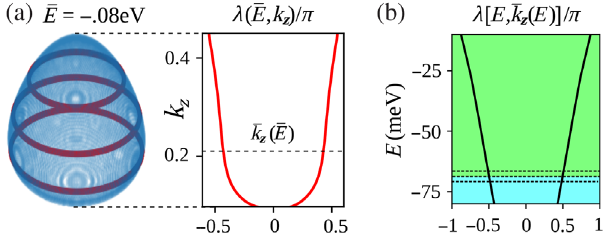
FIG. 3. Characterization of the 3D Dirac metal Na 3 Bi. (a) Left: ¯ E Surface of fixed energy ( ¼ − 0 . 08 eV measured from the 3D Dirac point); contours of fixed energy and k are illustrated by red z ¯ E; k circles. Right: Plot of f λ for a field parallel to the a ð z Þg a ¼ 1 ; 2 trigonal axis ( k ). k is measured in units where the reciprocal z z period ( 0 . 64 Å − 1 ) is unity; the minimum (maximum) k on the z plot corresponds to the south (north) poles of the constant-energy ¯ ¯ E k surface. The extremal orbit occurs at k Þ , indicated by a z ¼ z ð ¯ E; k E Þ(cid:3) vs E , for a range of E below the dashed line. (b) λ 1 ; 2 ½ z ð Dirac point.